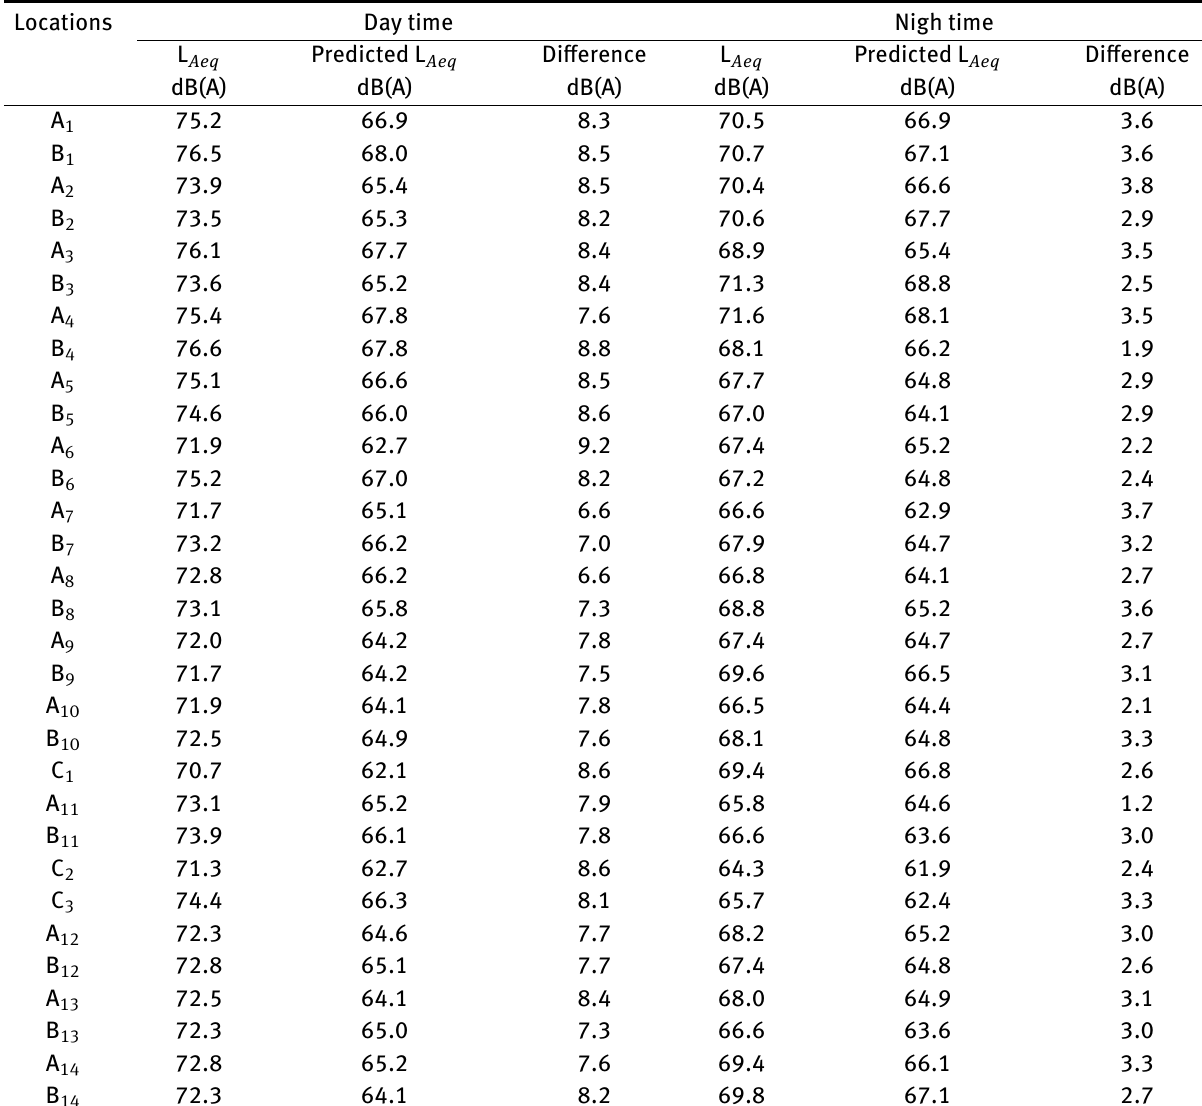
Table 1: Difference between Measured L Aeq and Predicted L Aeq − SoundPLAN (South-West zone) Locations